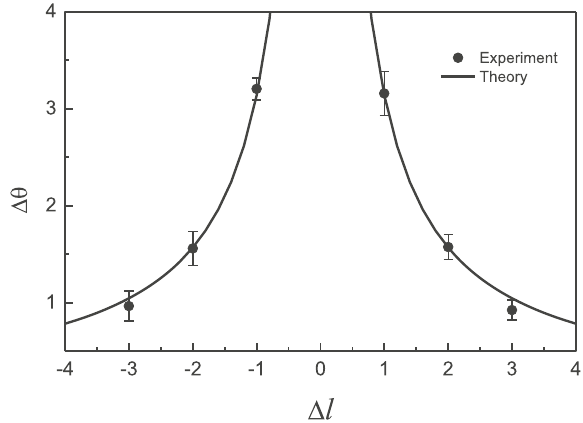
Fig. 4 Out-of-phase relation for different Δ l . Δ θ is plotted as a function of Δ l . From left to the right, Δ l = − 3, − 2, − 1, 1, 2, 3. The solid curve denotes the calculation of Eq. (5). The error bar is the standard deviation of six